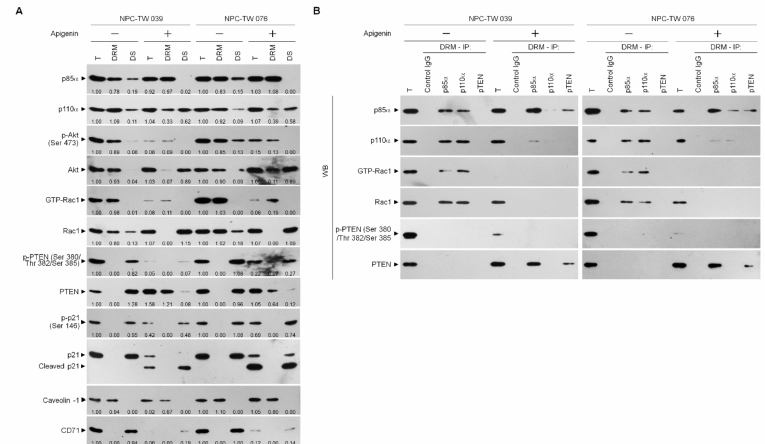
Figure 5. Apigenin induces p110 α -free p85 α –unphosphorylated phosphatase and tensin homolog deleted from chromosome 10 (PTEN) complex formation in the lipid raft membranes. ( A ) Nasopharyngeal carcinoma (NPC) cells were treated with vehicle ( − ) or apigenin (35 µ M) for 36 h. The levels of the indicated proteins in the lysates of vehicle- or apigenin (35 µ M)- treated total cell lysates (T), detergent-resistant membrane (DRM) and detergent-soluble (DS) fractions were determined by Western blot analysis using specific antibodies. The values above the figures represent relative density of the bands normalized to vehicle-treated proteins of T. ( B ) Coimmunoprecipitation of p85 α , p110 α , and PTEN was performed using the DRM fractions prepared from the cells treated as described above. The antibody used for coimmunoprecipitation is indicated at the top. The proteins from the immunoprecipitated complexes were detected using Western blotting with specific antibodies. Normal IgG was used as a control for antibody